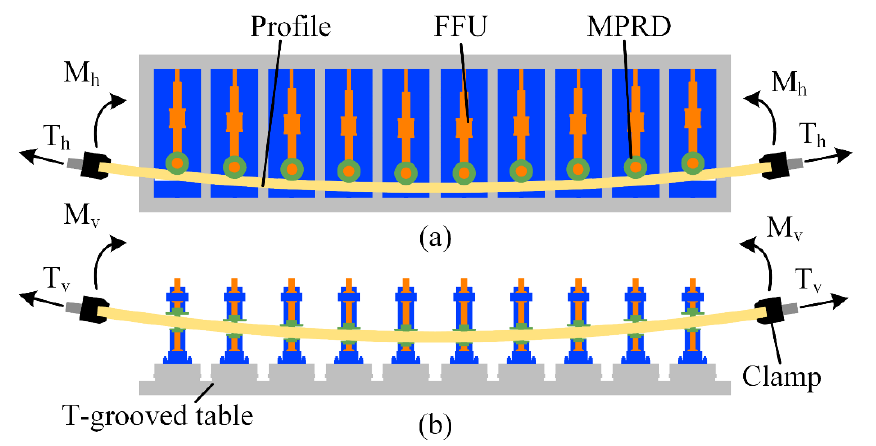
Figure 2. Forming principle of FSB-MPRD. ( a ) Horizontal bending process. ( b ) Vertical bending process.